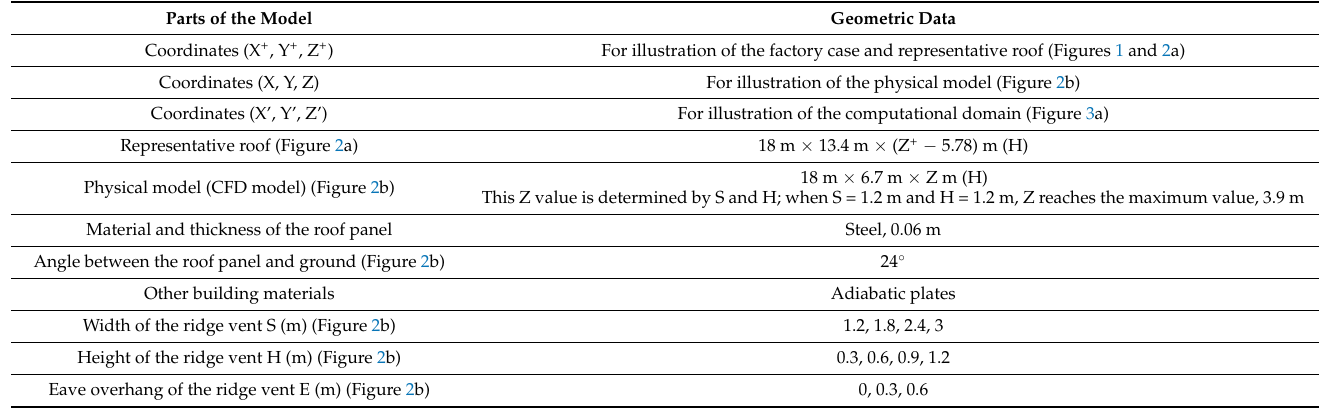
Material and thickness of the